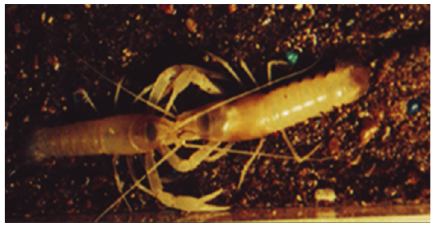
Figure 1: Blind cave crayfish, Orconectes packardi australis , engaged in an agonistic